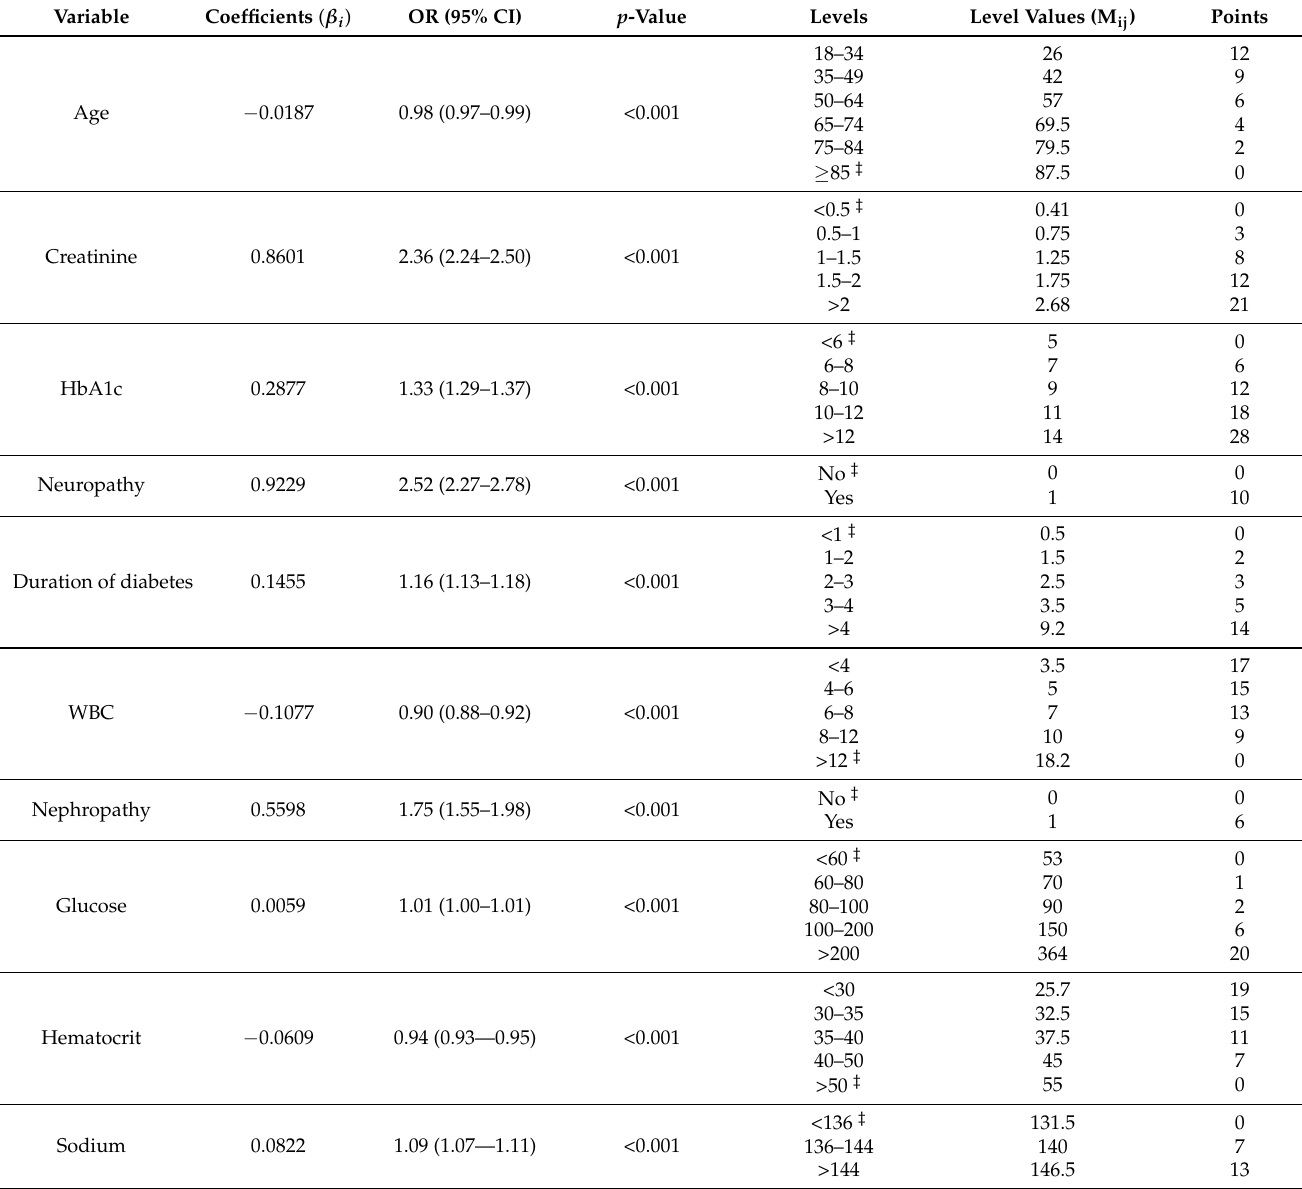
Table 3. Logistic regression results and risk scores for essential